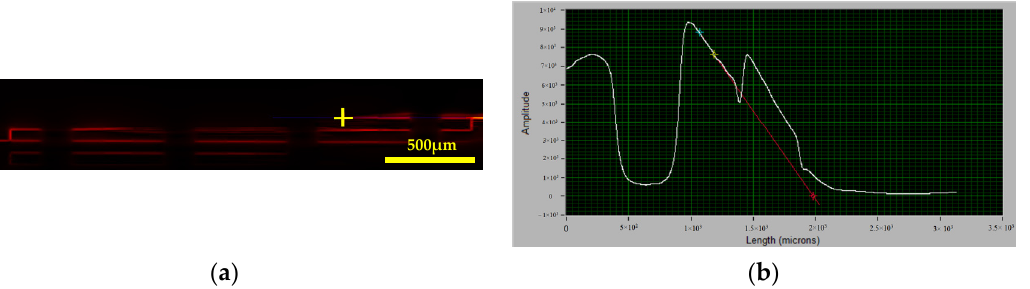
Figure 10). Given the proximity of the location to the via, the fifth via was viewed as the likely opening location.